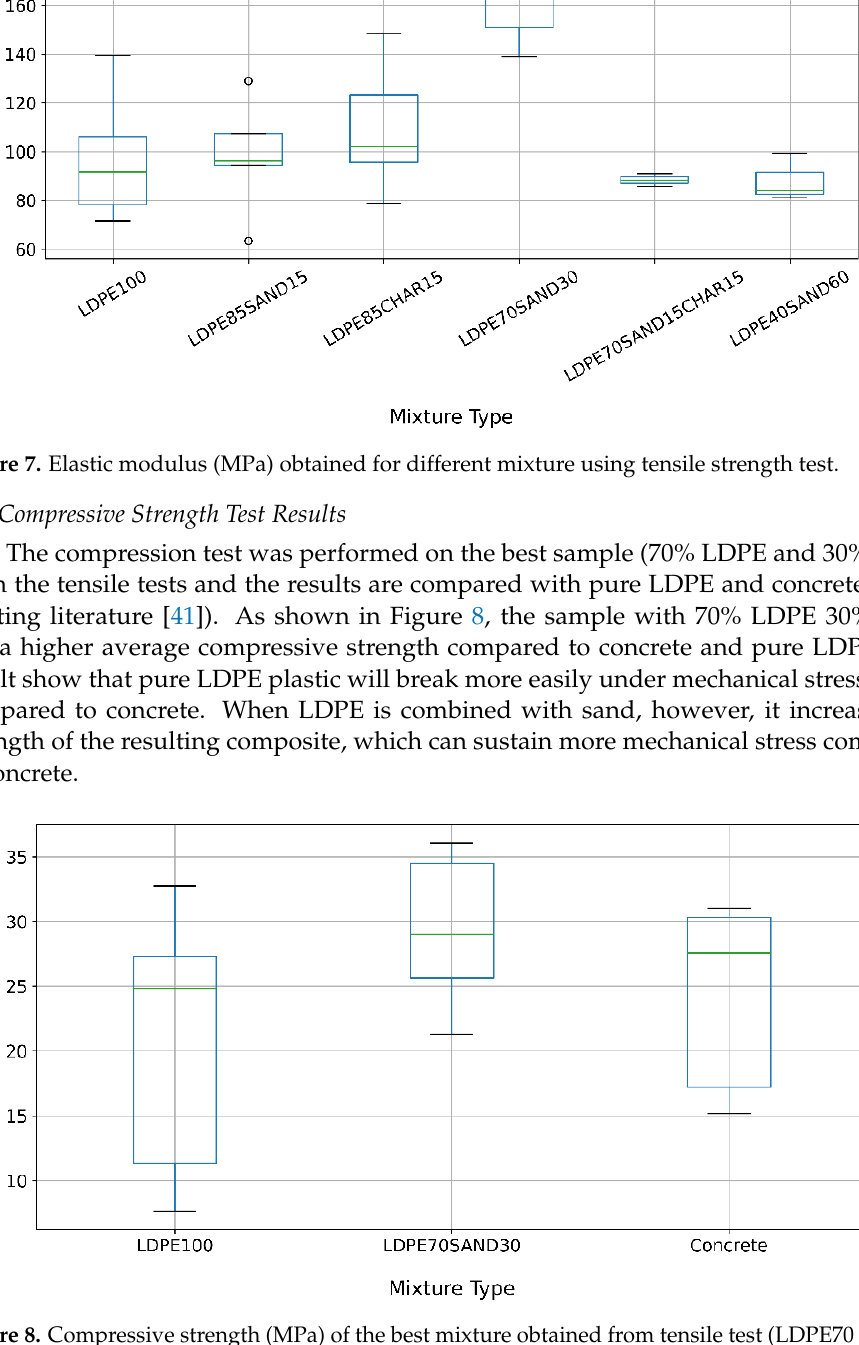
Table 2. Absorptivity (%) obtained for different mixtures using absorptivity test.